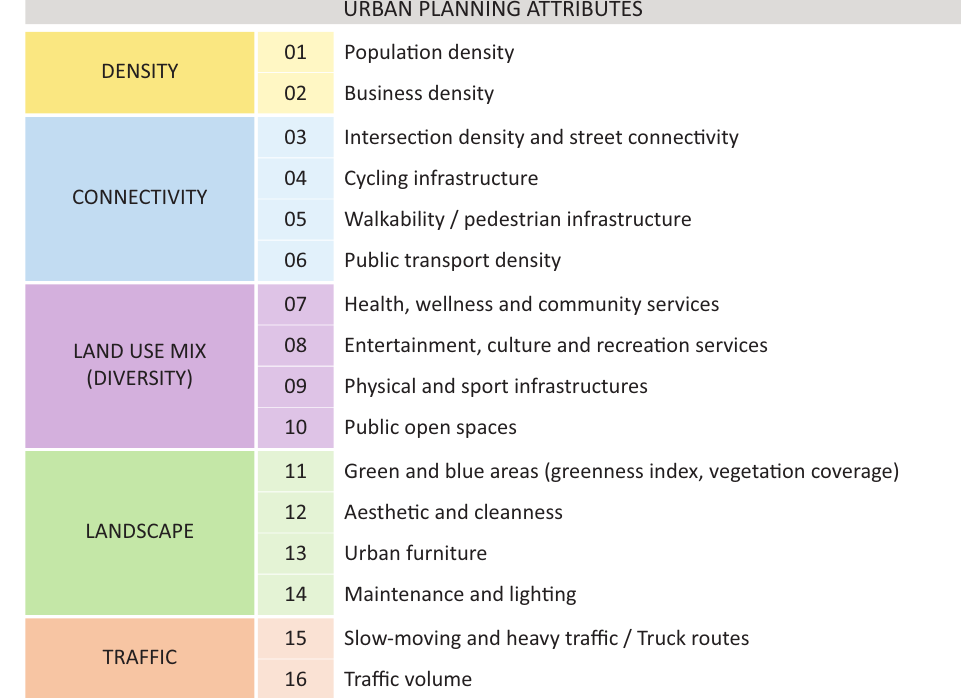
Figure 3. Urban planning attributes (n = 16) significantly associated with health indicators.